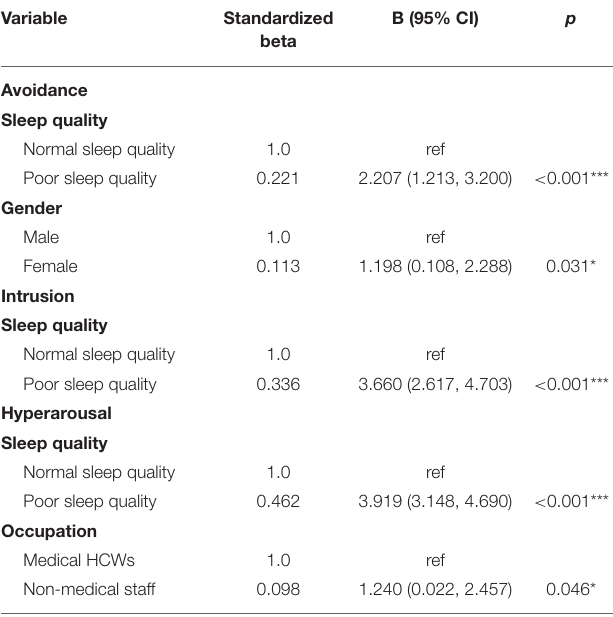
TABLE 6 | Multiple linear regression to predict PTSD